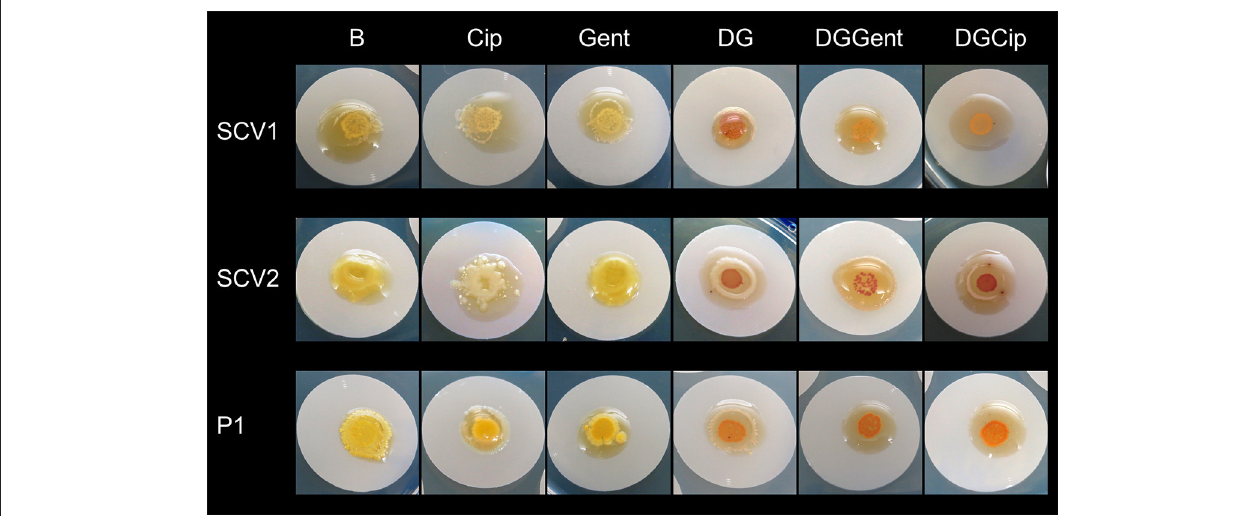
FIGURE 5 | Inhibitory effect of drug loaded hydrogels on biofilms after 5 days exposure. Elevated biofilm inhibition was observed for gels containing deferiprone, gallium-protoporphyrin and ciprofloxacin or gentamicin (DGCip, DGGent). Strains used: Small colony variant SCV1, SCV2 and parent strain P1. Hydrogels- B, Blank control gel; Cip, Ciprofloxacin 5 µ g/ml; Gent, Gentamicin 100 µ g/ml; DG, Deferiprone 20 mM-Gallium-protoporphyrin 100 µ g/ml; DGGent, Def-GaPP100-Gent; DGCip, Def-GaPP100-Cip.